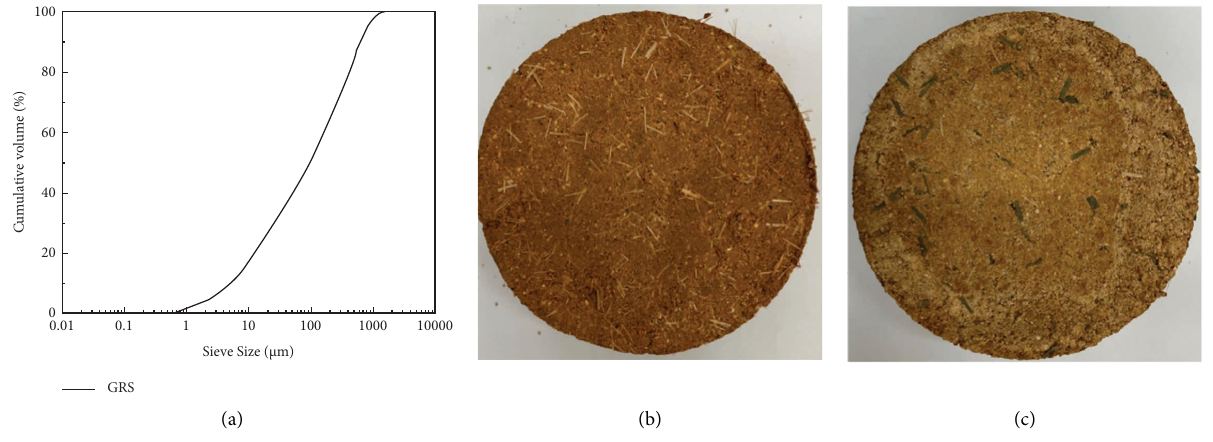
Figure 3: (a) GRS size, (b) glass fber sample, and (c) basalt fber sample. Table 3: Te unconfned compressive strength test plan.